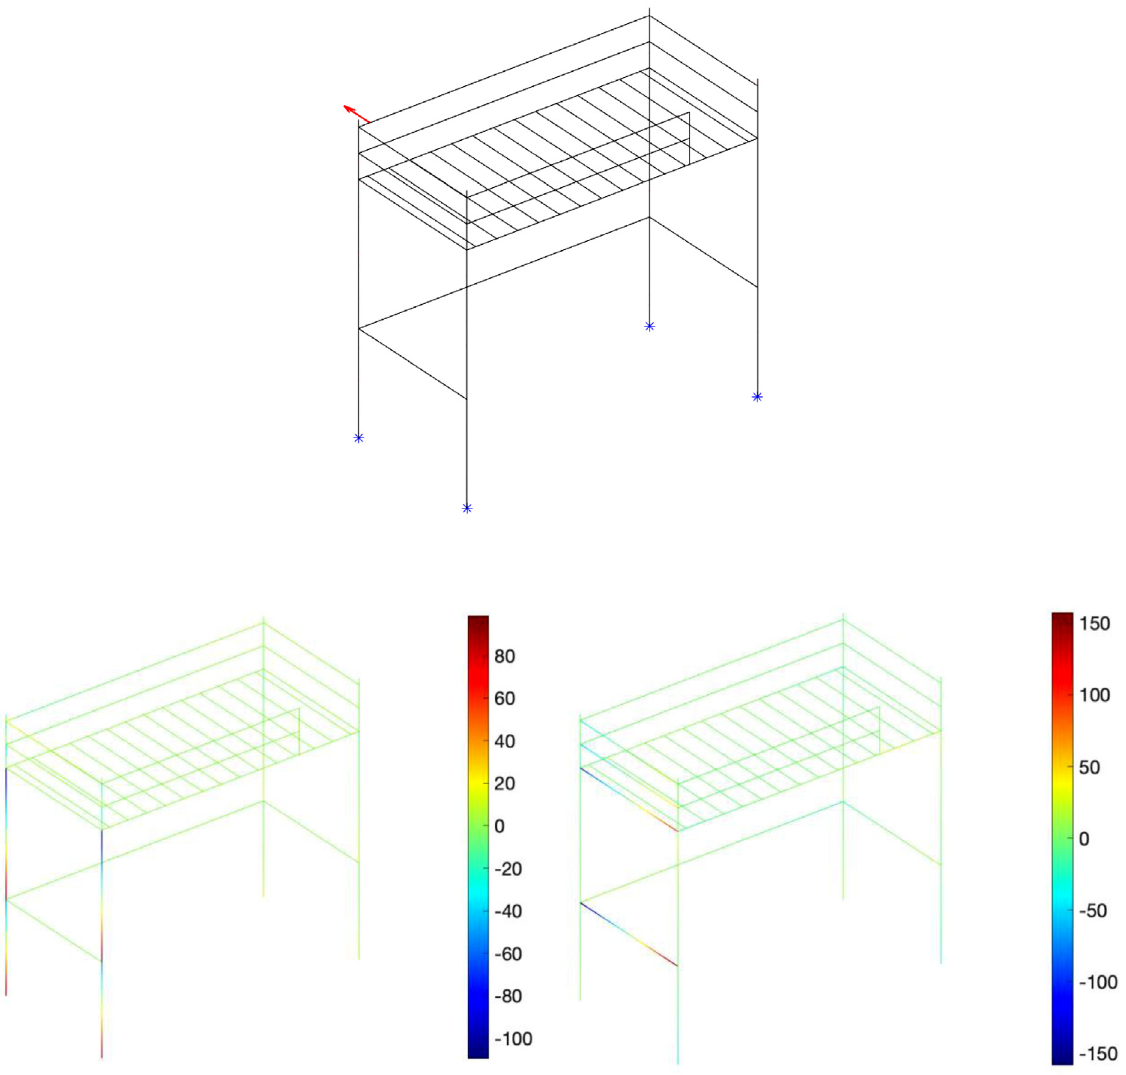
Fig. 16. High loft bed modeled by a beam assembly (top), bending moment in the vertical bed posts (bottom left), and bending moment in the horizontal beams (bottom right), with values given in [N ⋅